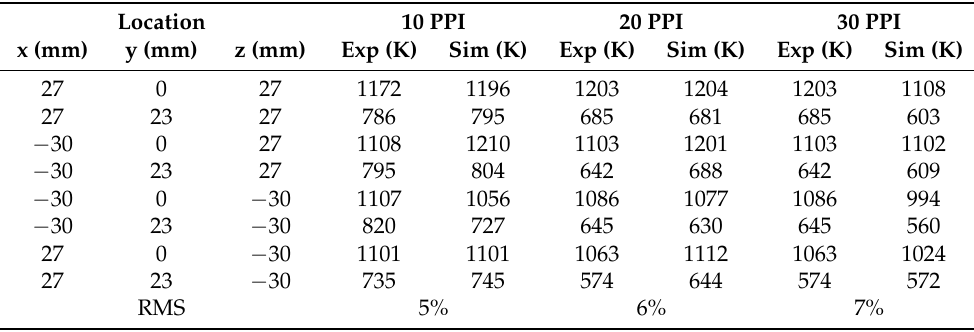
Table 1. Experimental (Exp) temperature data in the porous medium and simulations (Sim) pre- dictions for the 10, 20, and 30 PPI absorbers, with 30 L/min − 1 in air flowrate. RMS refers to root-mean-square deviations.